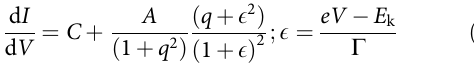
offset of the spectra representing background conductance through other channels; A is the amplitude of the resonance; q is the ratio of tunnelling into the resonance and into the continuum 6 ; E k is the offset from the Fermi energy (zero bias); G is the resonance width; and V is the bias voltage. Such a feature is created when two coherent tunnelling paths interfere with each other, where one path is into a sharp resonance and the second is into a broad continuum 28 . The line width G is related to the strength of the interaction between the resonance and continuum, and the amplitude of the Fano line shape A is determined by the continuum of the system.